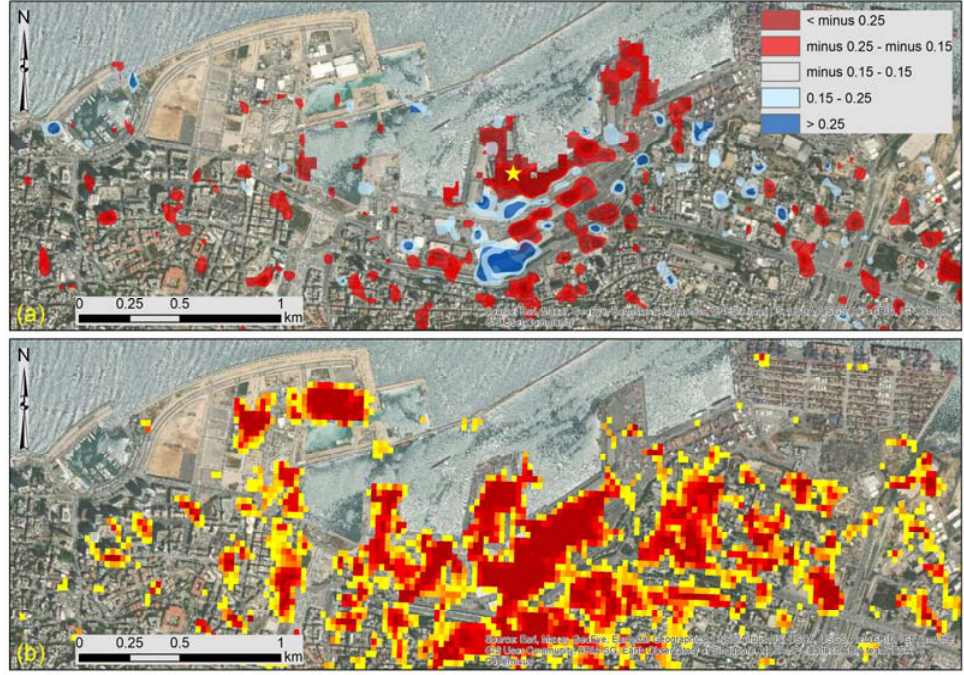
Figure 11. ( a ) Change detection results as generated from the VV and VH log differences of the Sentinel-1 images, while ( b ) indicates the Damage Proxy Map generated from the Advanced Rapid Imaging and Analysis (ARIA) team [8]. The location of the blast size is shown with the yellow star.